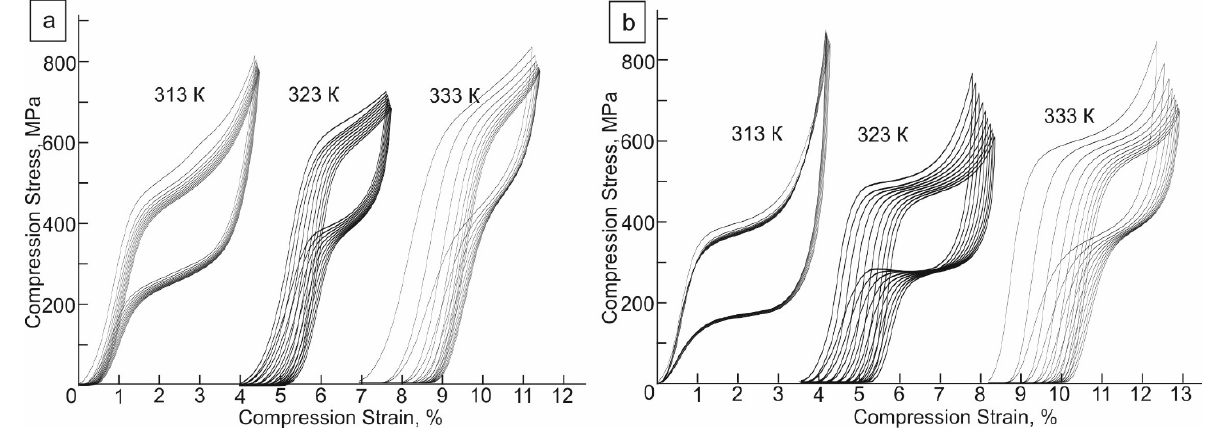
Figure 6. Superelastic cycles ( n = 10) of [011]-oriented Ti-50.1Ni single crystals: ( a )—annealing at 713 K for 0.5 h in helium gas; ( b )—annealing at 713 K for 0.5 h in dry air.